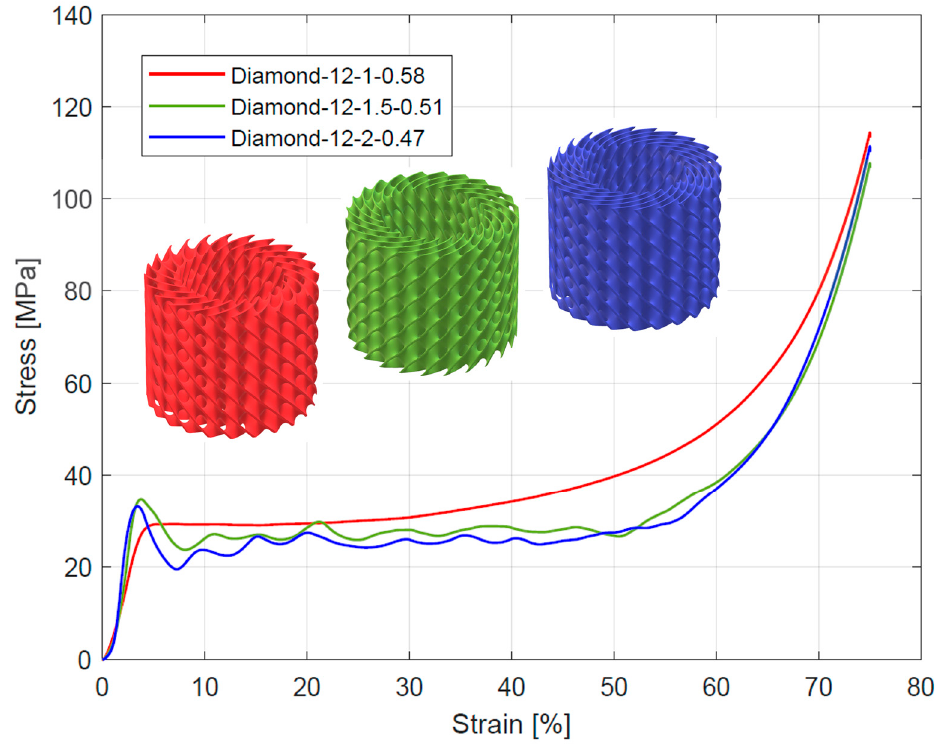
Figure 8. Stress–strain curves from compressive testing of Diamond TPMS cylindrical structures with 12 unit cells in a circumferential direction.